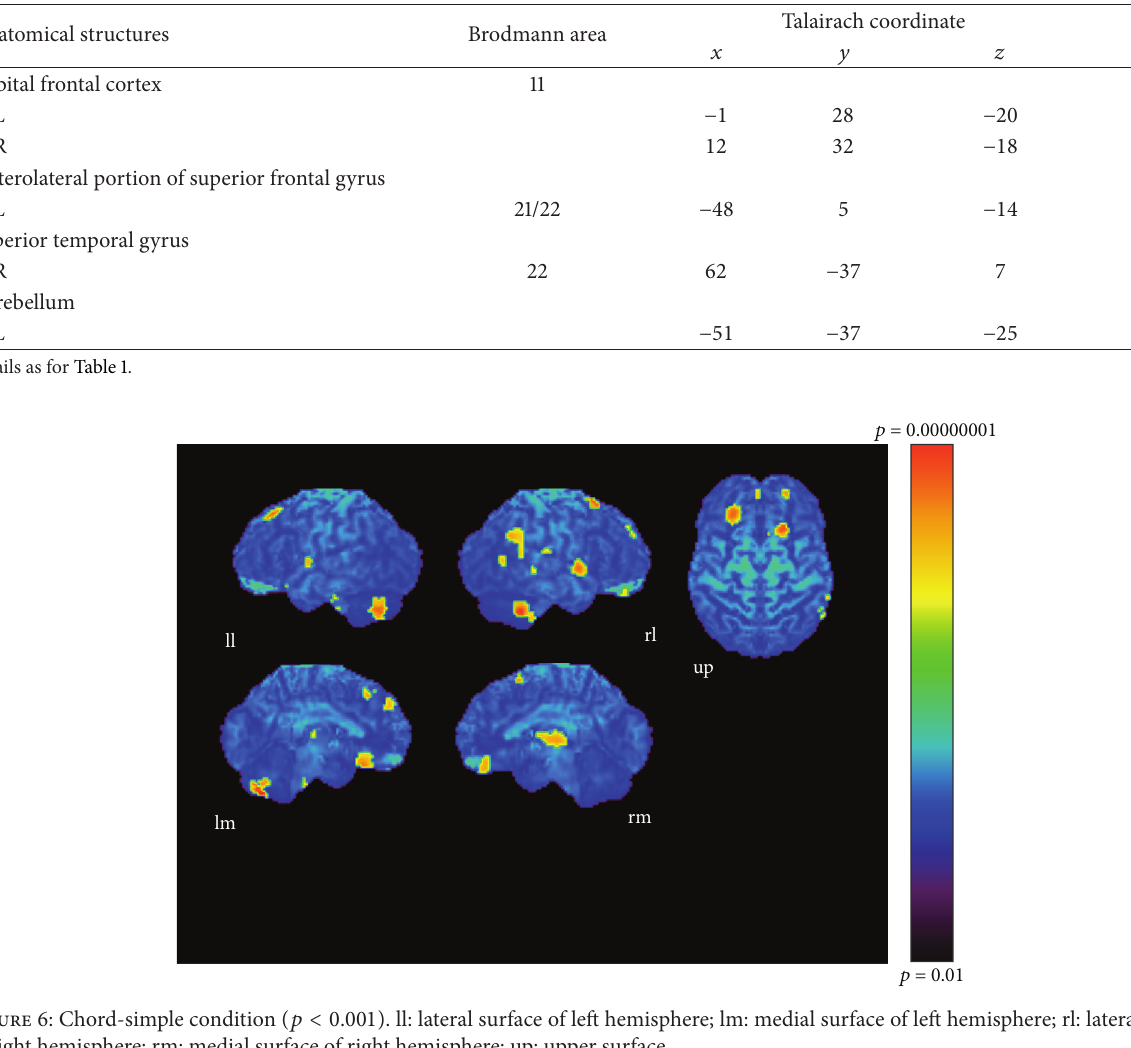
Table 6: Regions showing significant changes in rCBF by the subtraction of simple minus complex condition 3.